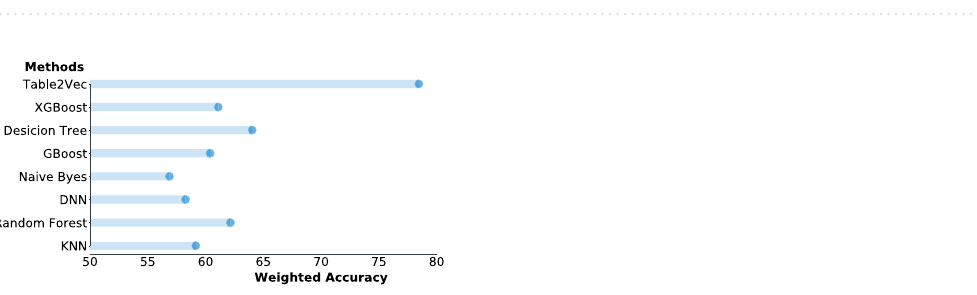
Figure 11. The ROC results of shallow and deep models versus Table2Vec-based classification on the Kaggle data set.